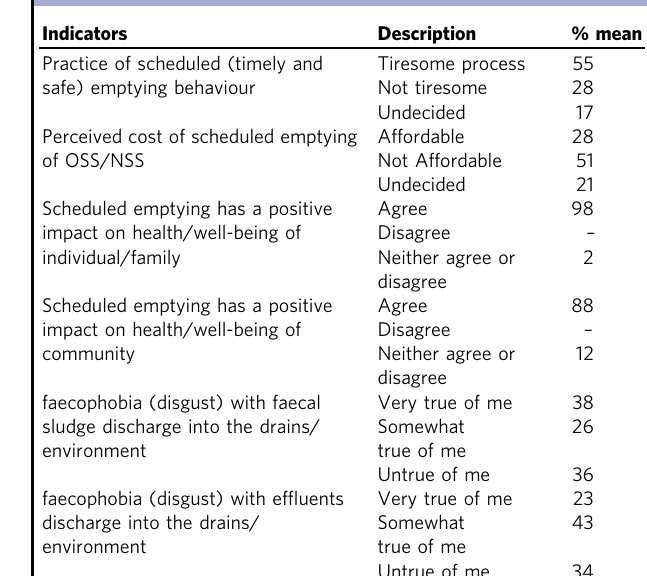
Table 3 Perception of scheduled (timely and safe) emptying